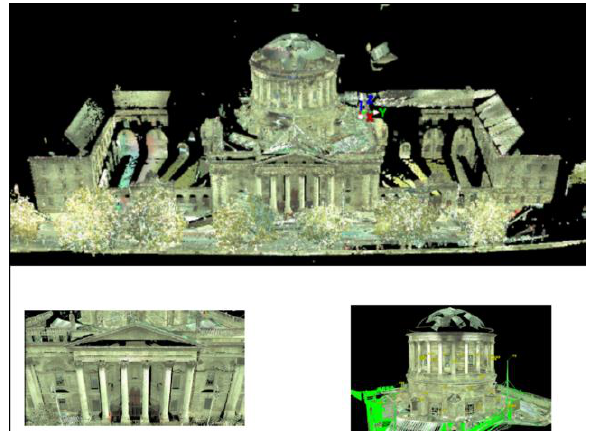
Figure 2: Laser Scan Survey